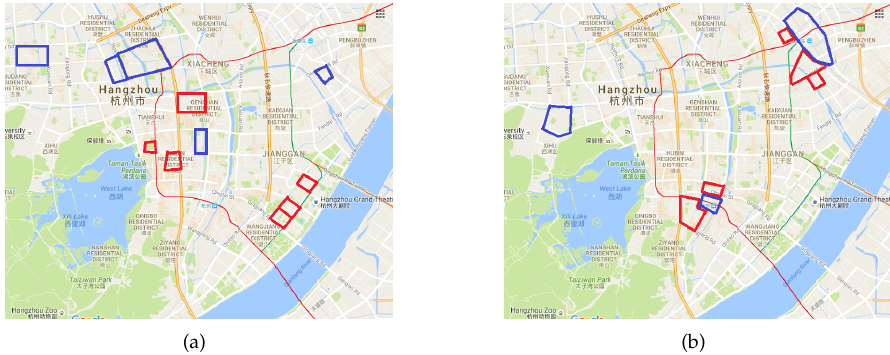
Figure 5. Traffic pattern analysis in Hangzhou. ( a ) Traffic pattern at 9:00; ( b ) Traffic pattern at 20:00.